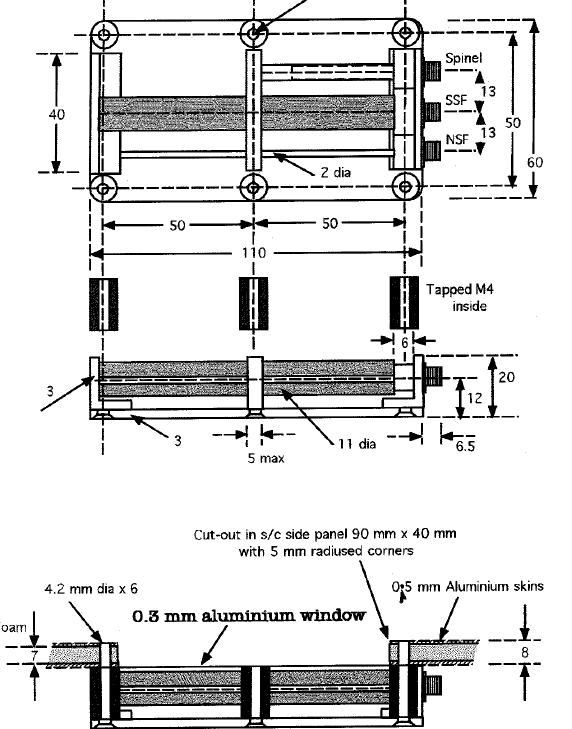
Fig. 1. Mechanical assembly of the Scintillating Fibre Detector built and calibrated by SENSYS/Noordwijk, under ESA contract No. 10988/94/NL/NB